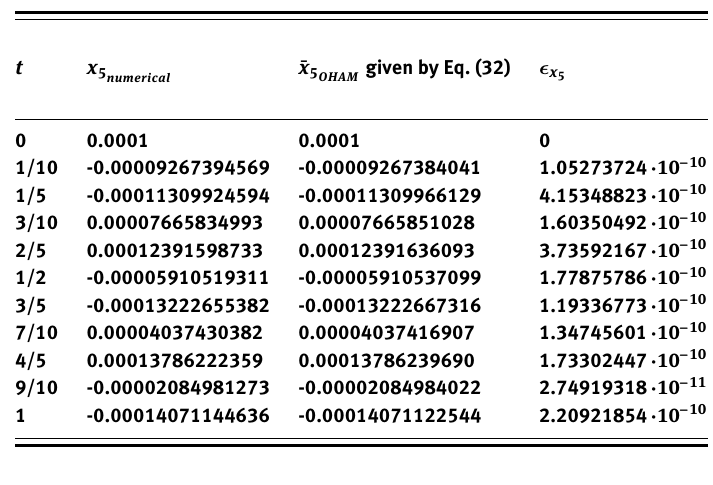
= ∣ x 5 − ¯ x 5 ∣ ) 5 OHAM numerical